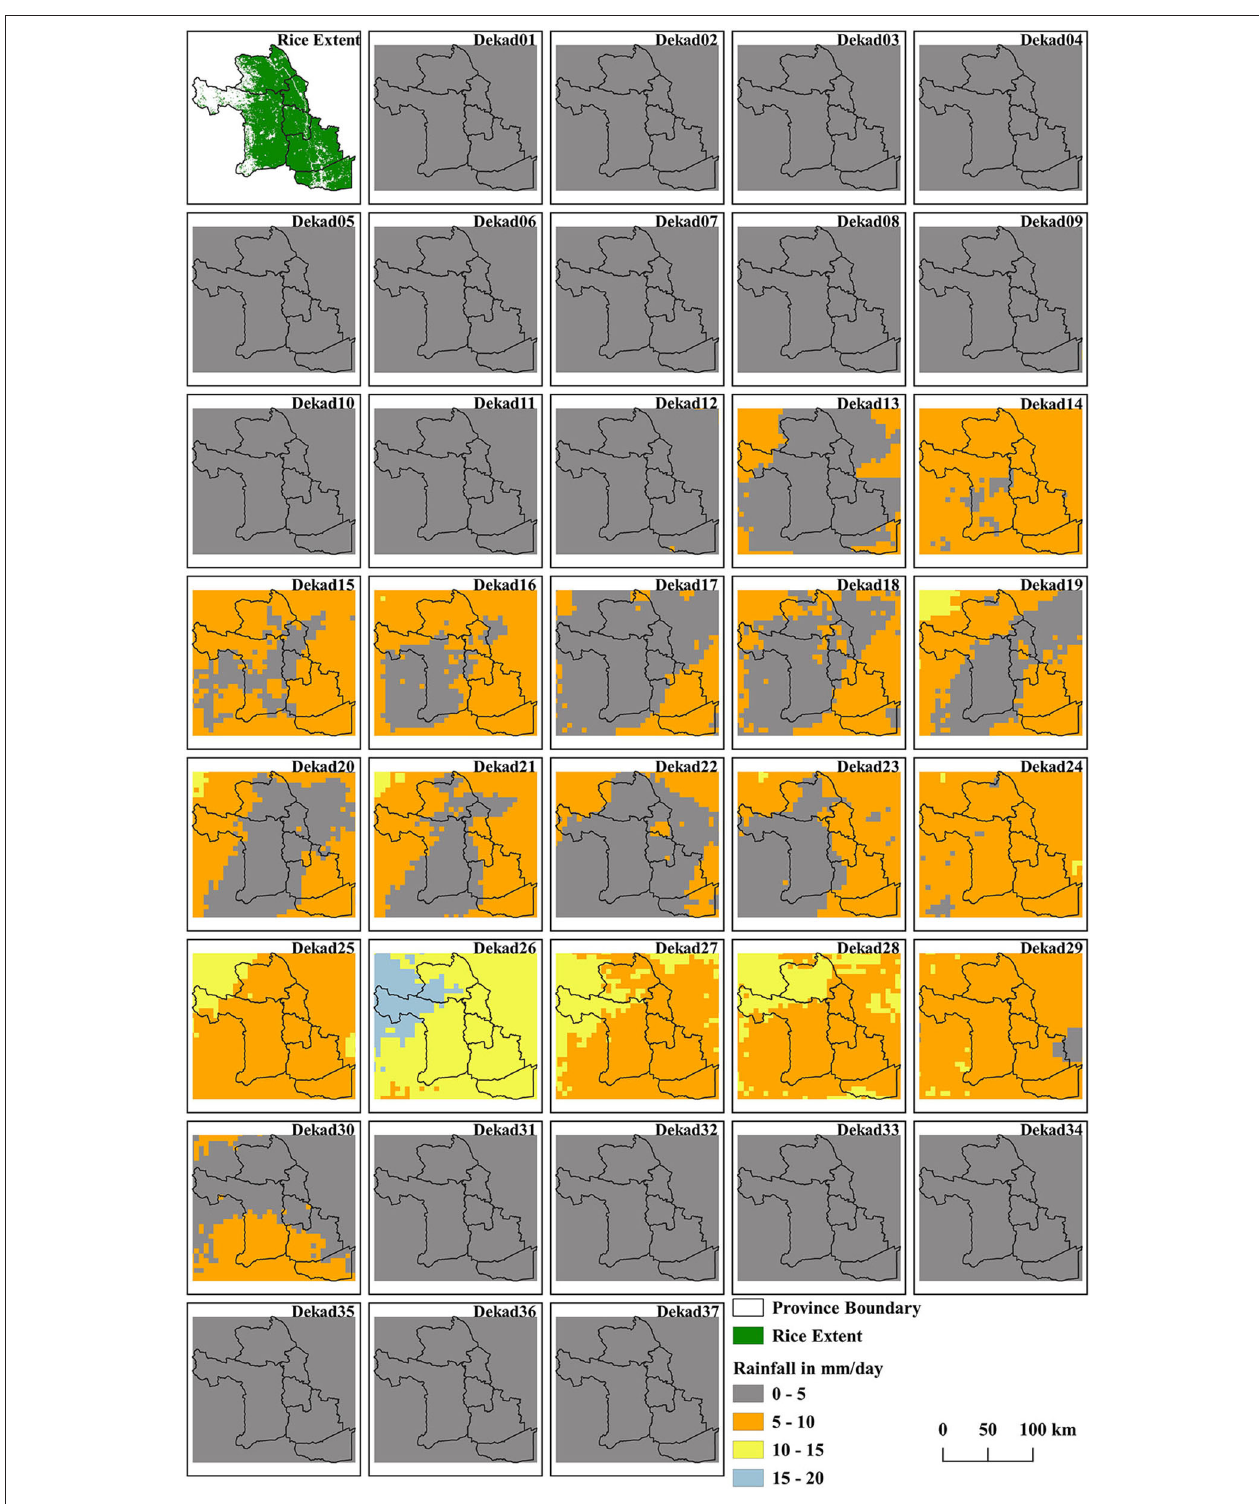
FIGURE 3 | Eleven-years mean rainfall in the target area per dekad.